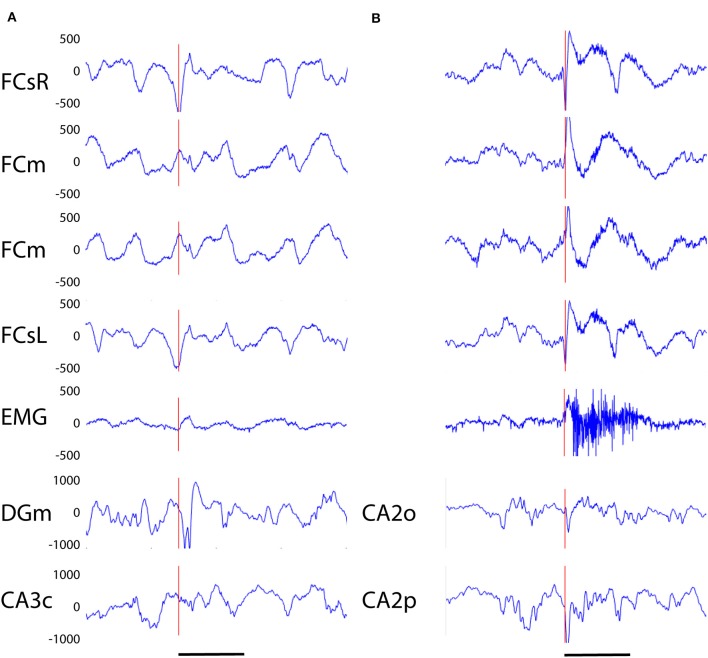
(A) Example of a cortico-hippocampal (CH) spike recorded from an APP/PS1 mouse. The spike (vertical red line) begins 2–3 ms earlier on the left frontal screw channel than the right one and is followed by a double spike in the hippocampus (DGm) ~10 ms later. (B) Example of a CH spike with a muscle twitch from an APP/PS1 mouse. A simultaneous spike on left and right frontal screw channels is immediately followed by a surface-positive spike on medial frontal channels and a spike on hippocampal channels, and with a slight delay by a 200 ms high-frequency activation of the EMG. Channel abbreviation as in Figure 2, except DGm, dentate gyrus, molecular layer; CA3c, hippocampal pyramidal cell layer CA3c. CA2o, hippocampal CA2, stratum oriens, CA2p, CA2, stratum pyramidale. Scale bar, 200 ms.